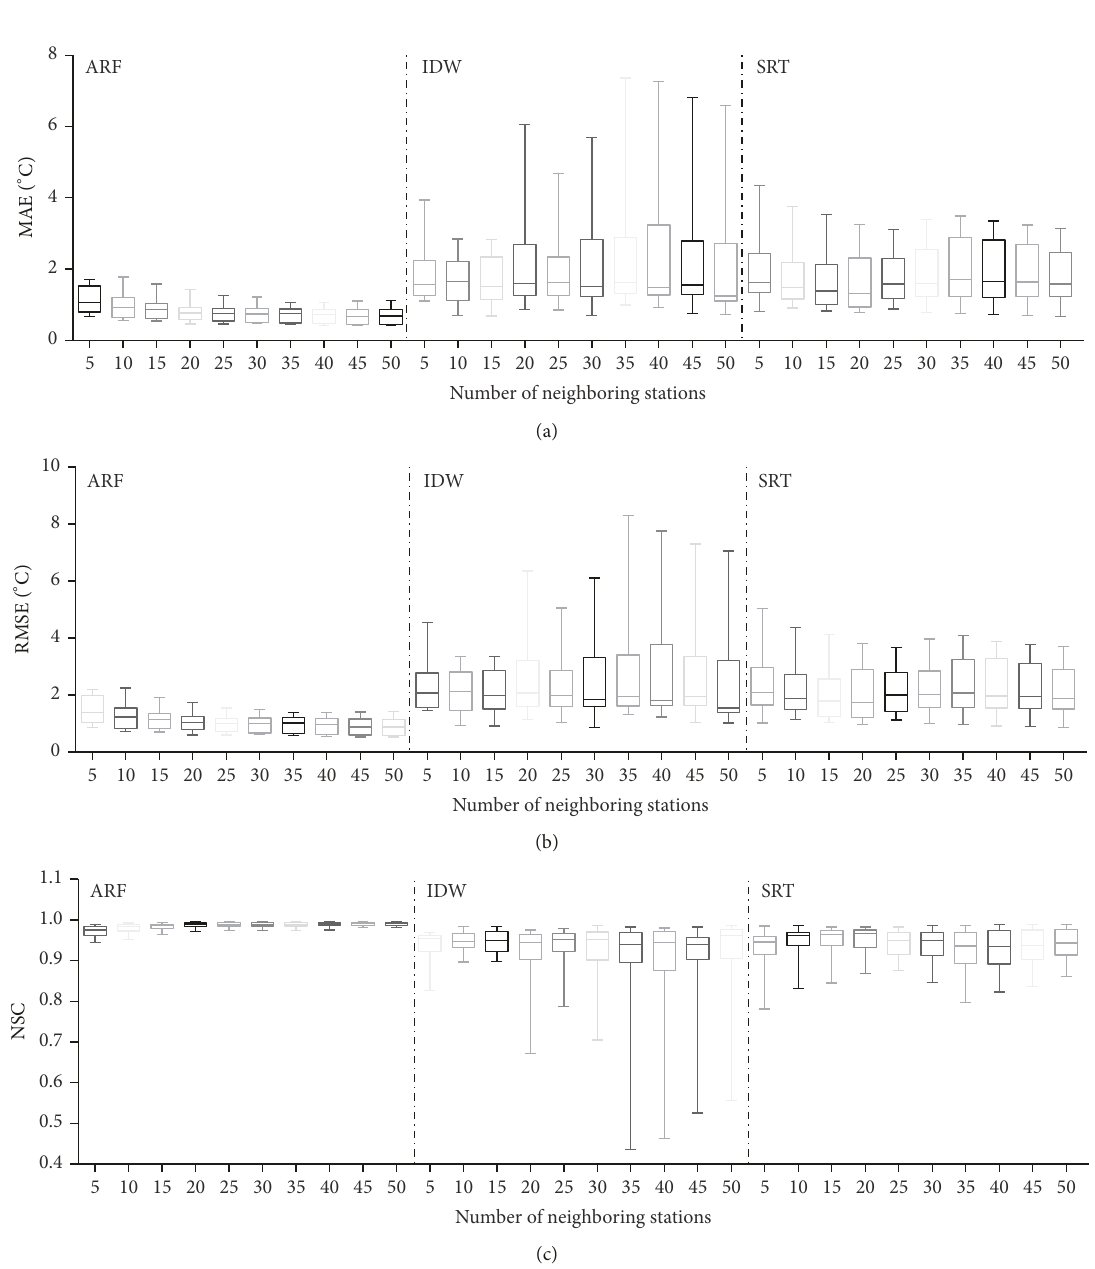
Figure 6: Performance indexes for different numbers of neighboring stations at different times for the IDW, SRT, and ARF methods: (a) MAE, (b) RMSE, and (c)